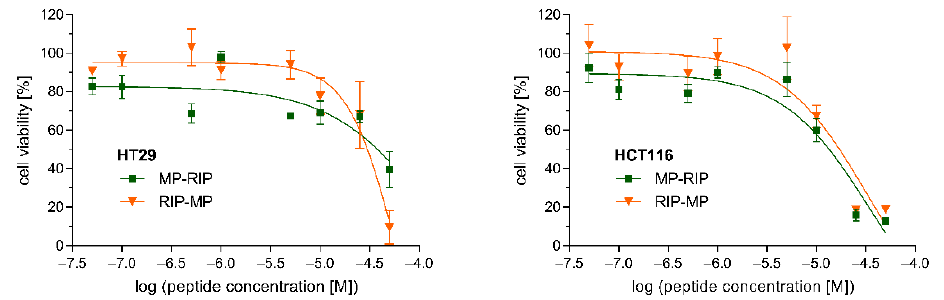
Figure 3. Examples of helical wheel projection for MP and its selected analogs. In this view through the helix axis, the hydrophilic residues (K, N, G, S, T) are located on one side and the hydrophobic residues (L, A, I, F, W, Y) on the other side of the helix. The arrow shows the hydrophobic moment ( µ H) vector. N— N -terminus; C— C -terminus. Helical wheel projections were made with HeliQuest https://heliquest.ipmc.cnrs.fr/ (accessed on 1 June 2022).